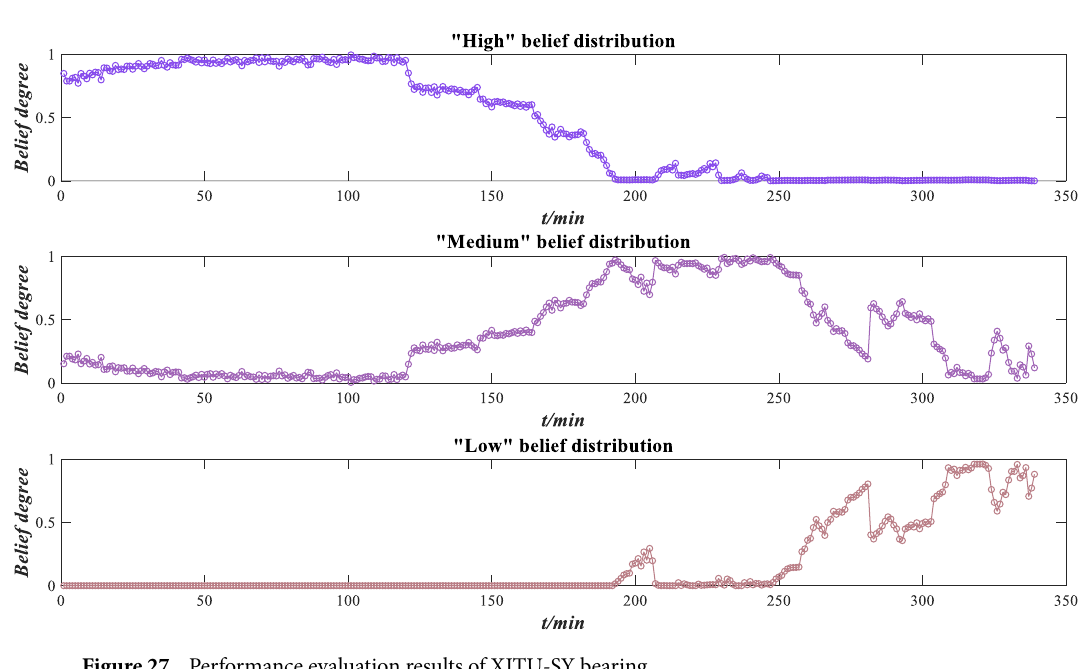
Figure 27. Performance evaluation results of XJTU-SY